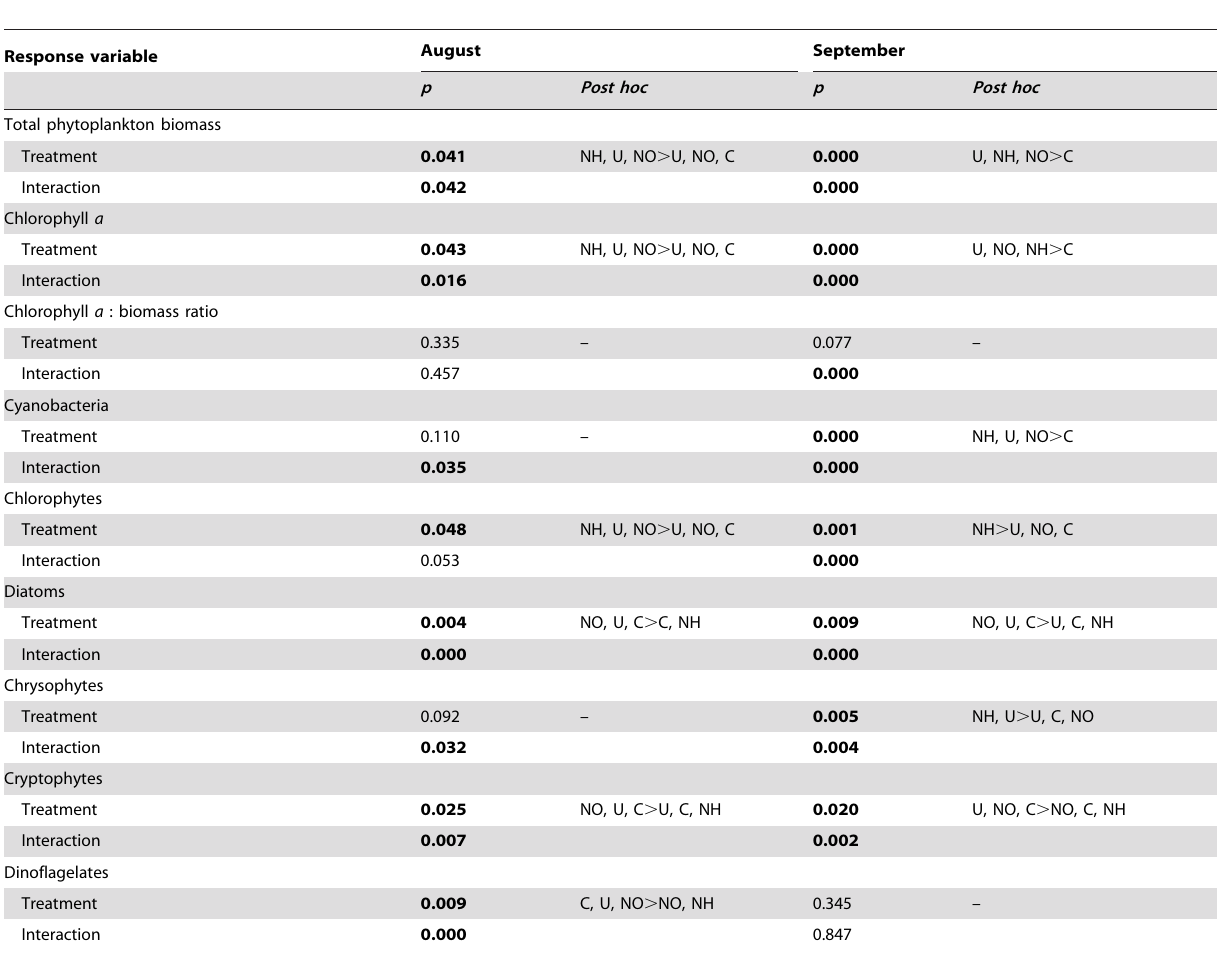
Table 1. Repeated-measures analysis of variance of total phytoplankton biomass, chlorophyll a , chlorophyll a : biomass ratio, and biomass of major algal